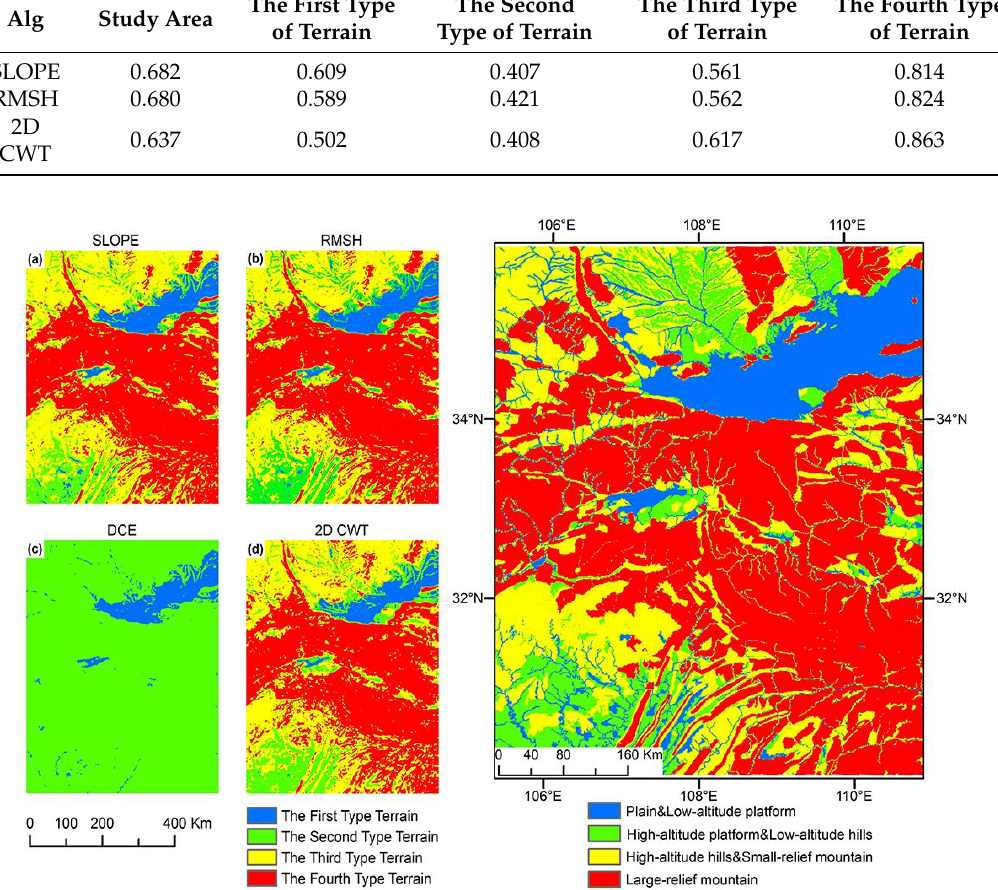
Figure 10. Results of the terrain partition based on geomorphological types and different roughness algorithms in the study areas. ( a ) Results of the terrain partition of SLOPE; ( b ) Results of the terrain partition of RMSH; ( c ) Results of the terrain partition of DCE; ( d ) Results of the terrain partition of 2D CWT.